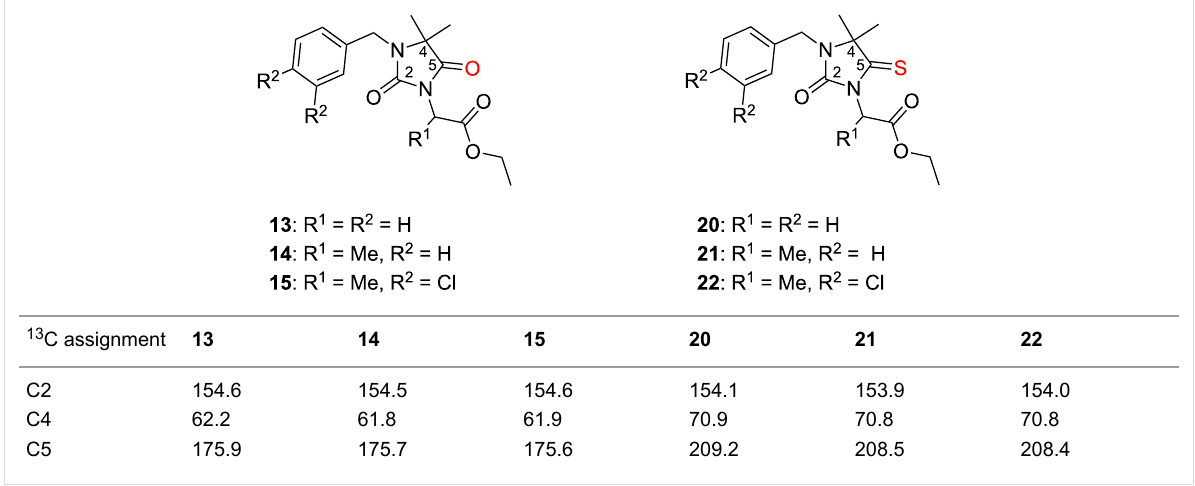
In the case of C5-thionation, the 13 C NMR signal for this carbon atom is shifted from about 176 to 208–209 ppm. In addition, the C4 signal is shifted from ca. 62 to 71 ppm upon